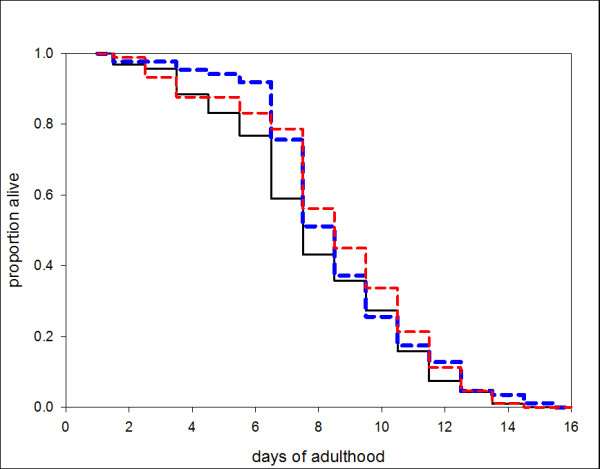
The lifespan of free-living P. trichosuri adults, incubated in various liquid medium. P. trichosuri free-living worms were reared until L4 stage (approximately 36 to 48 hours). At least 85 individual worms were plated in 96-well plates containing liquid nematode growth medium with low peptone, red line, that was either 50% conditioned medium (supplemented with semi-purified conditioned medium to a ratio of 1:10), black line; or in 50% bacterial conditioned media control (BAC), blue line. The worms were cultured at 20°C and observed daily. Worms were scored as dead when they no longer responded to touch. There was no significant difference in lifespan between the various culture media.